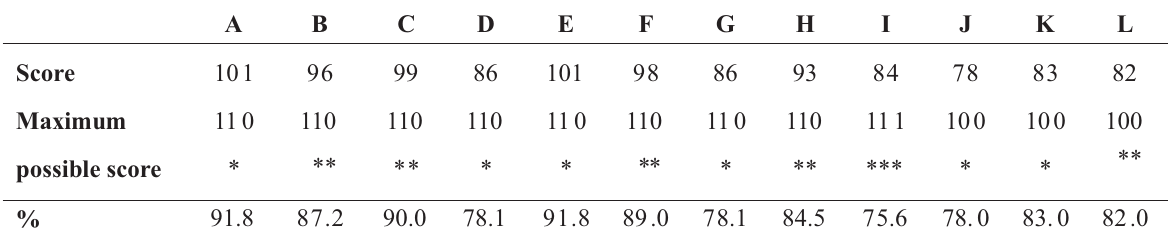
Table 3: Distribution of the total aggregated score of Dermatology clinics in the Western Province A B C D E F G H